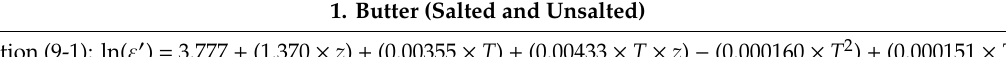
Table 9. Study of the e ff ect of two categories on the dielectric properties of butter and eggs using regression